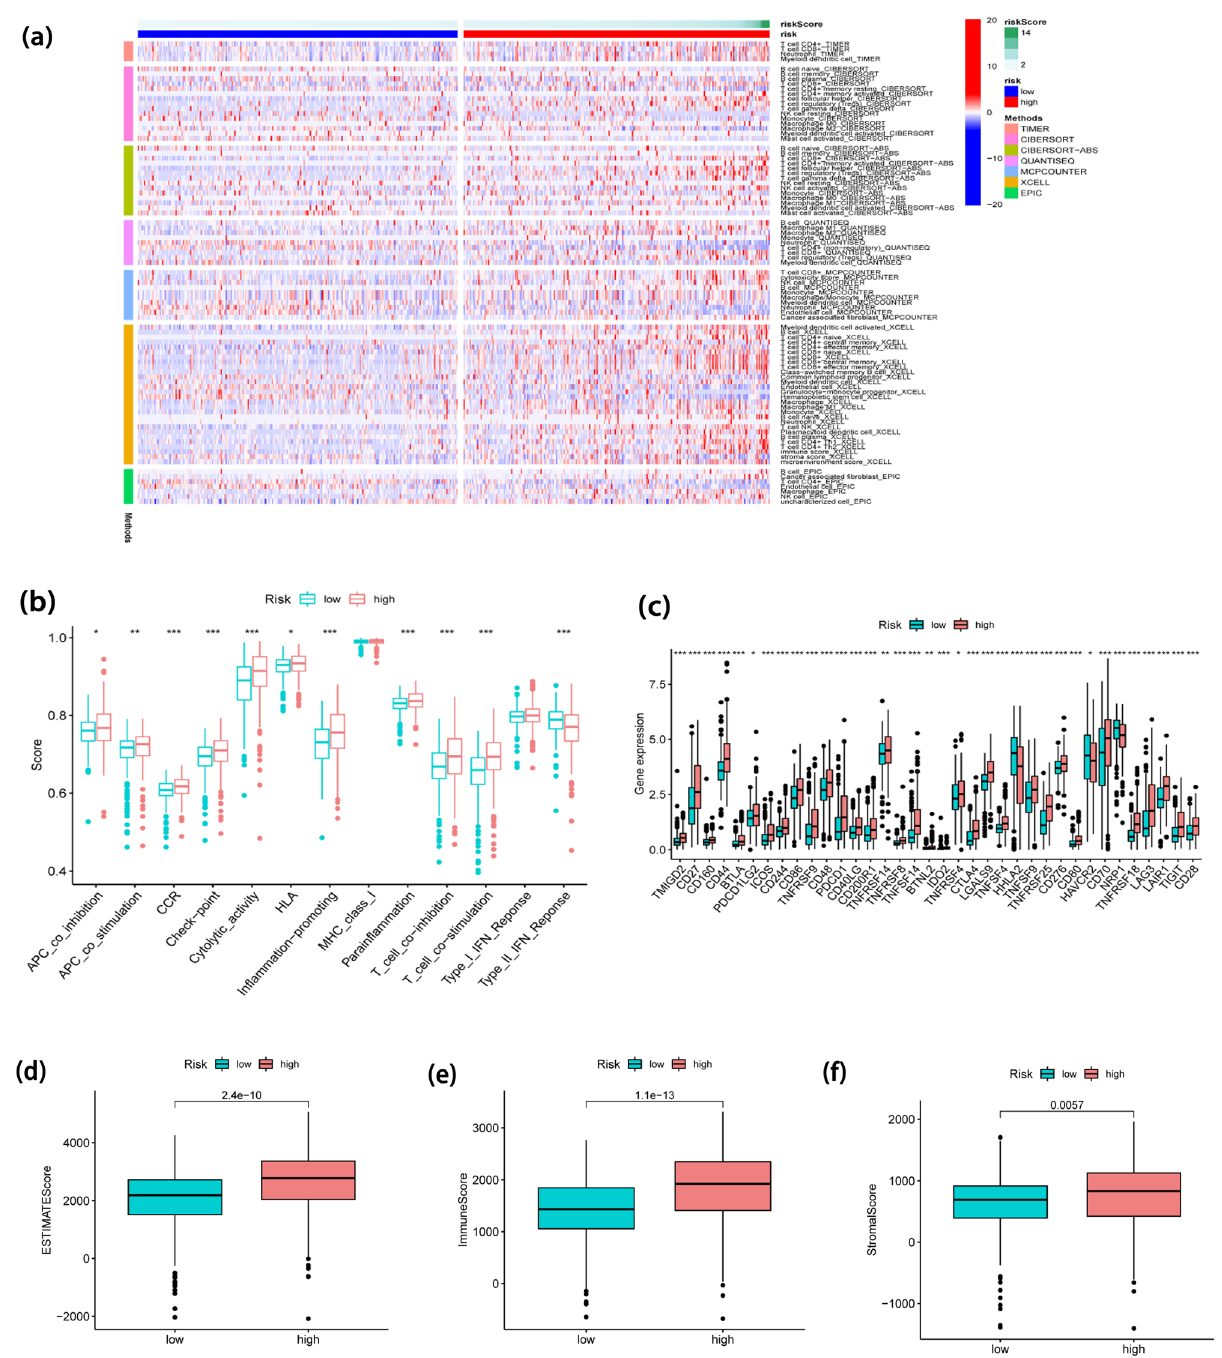
Figure 10. The relationship between FLPS and immunological infiltration landscape. ( a ) Heatmap for tumor- infiltrating immune cell types. ( b ) The immune-associated activity. ( c ) Expression of the immune checkpoint. ( d – f ) Comparison of ESTIMATE, immune, and stromal scores in two